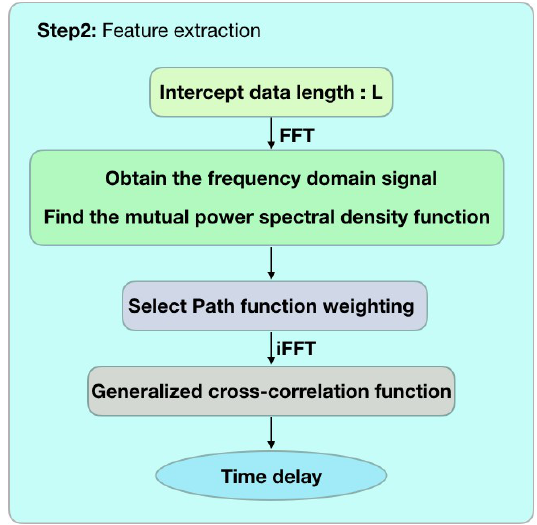
Figure 4: Delay feature extraction flow chart